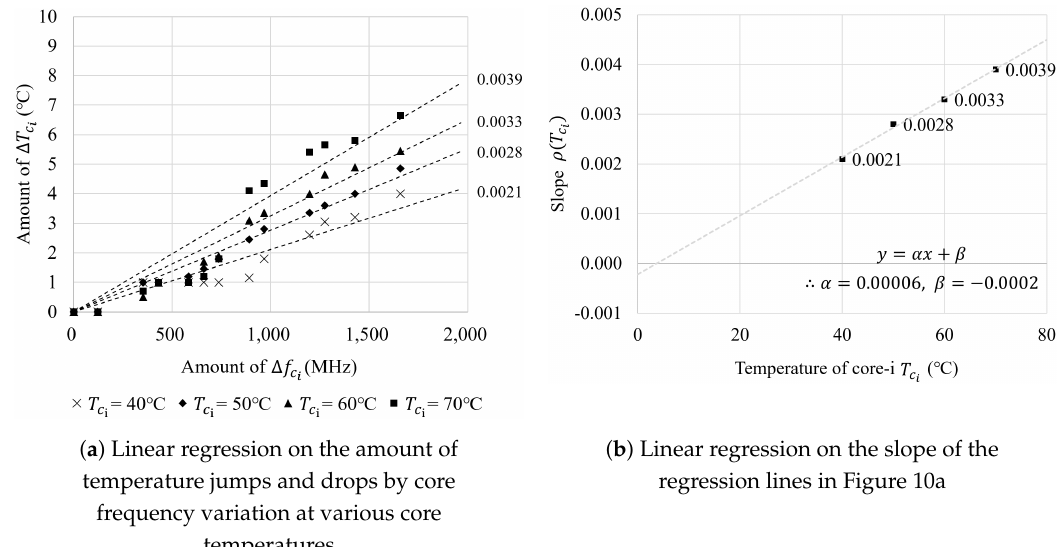
Figure 10. Result of linear regression for formula construction of thermal